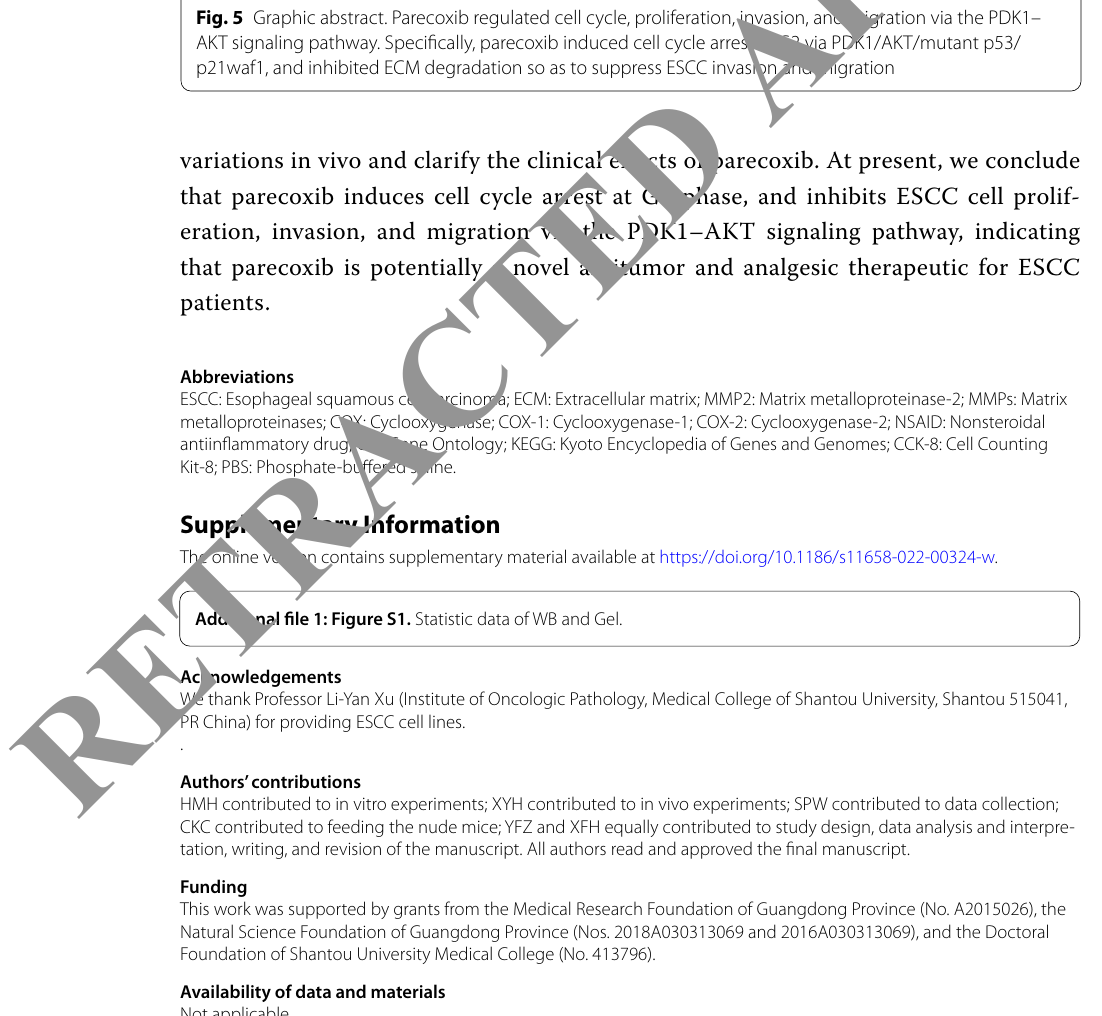
Fig. 5 Graphic abstract. Parecoxib regulated cell cycle, proliferation, invasion, and migration via the PDK1– AKT signaling pathway. Specifically, parecoxib induced cell cycle arrest at G2 via PDK1/AKT/mutant p53/ p21waf1, and inhibited ECM degradation so as to suppress ESCC invasion and